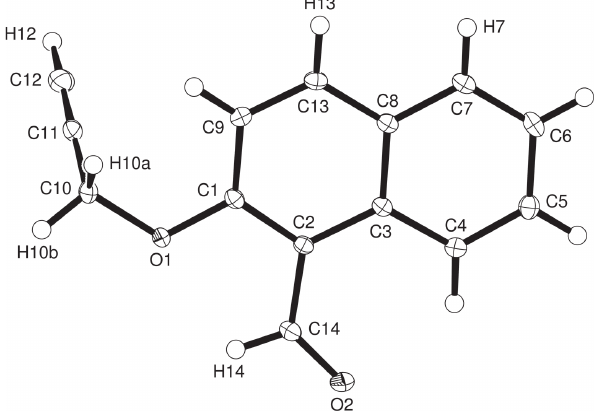
Table 2: Fractional atomic coordinates and isotropic or equivalent isotropic displacement parameters (Å 2